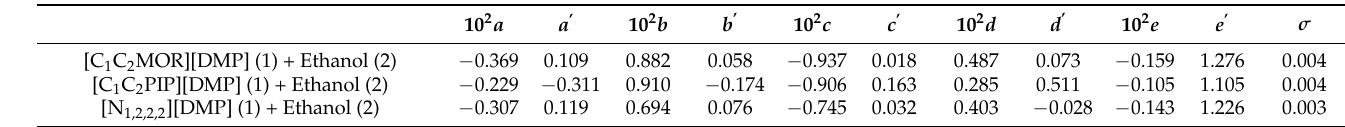
Table 10. The parameters of Equations (12) and (13) for correlation composition dependence of the density of {IL (1) + Ethanol (2)} binary systems a